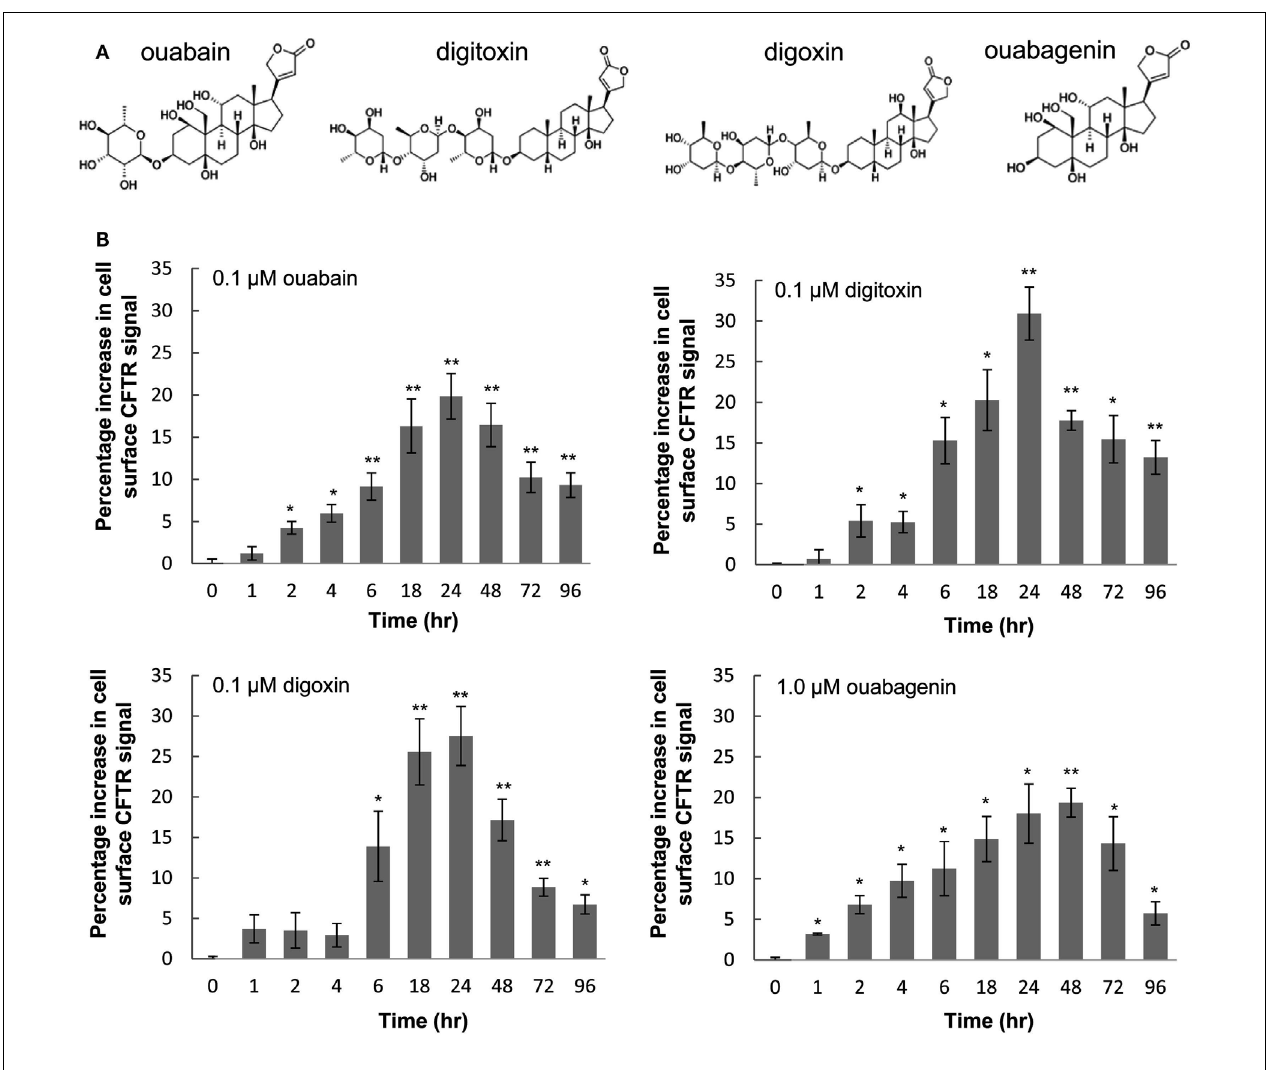
points or with the vehicle control (0.1% DMSO), the cell surface expression of CFTR were monitored by immunofluorescence assay. Data are presented as percentage increase in surface CFTR signal compared to controls (mean ± SD of n = 4; * P < 0.05, ** P <